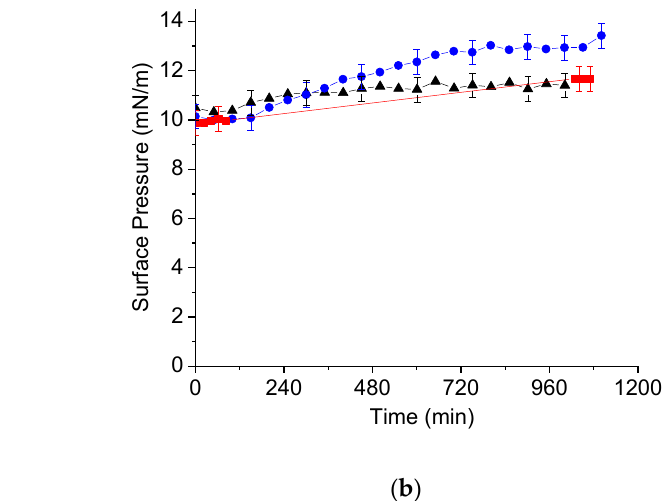
Figure 1. Kinetic dependencies of surface pressure ( a ) and elasticity ( b ) of lysozyme layers after a DNA injection into the subphase. The total DNA concentration is 14 μM , and the initial surface pressure is 10 mN/m. The three sets of experimental data correspond to different independent measurements. Lines are guides for the eye.